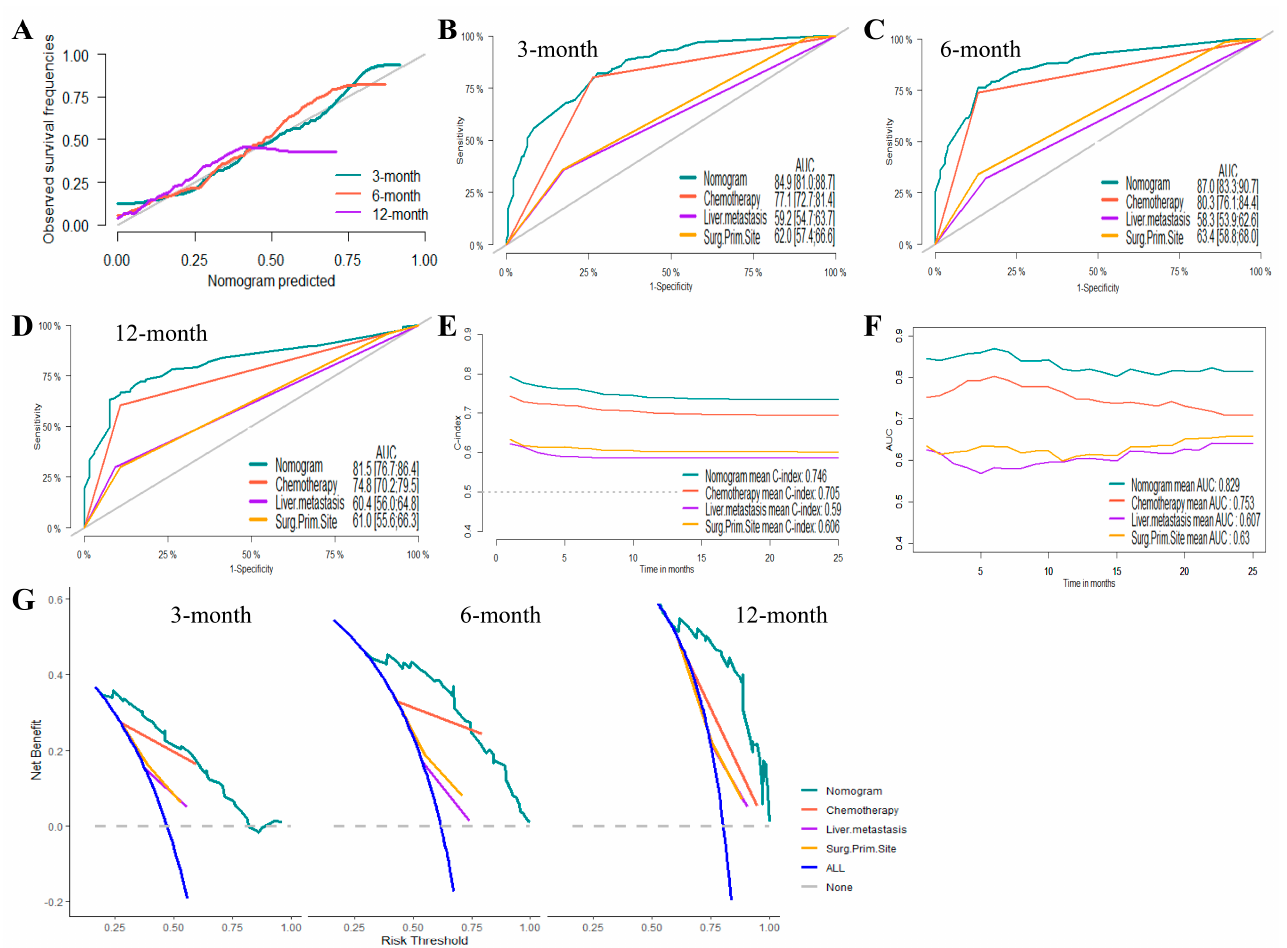
Figure 5. Evaluation of the nomogram on the internal validation dataset for cancer-specific survival (CSS). ( A ) 3-, 6-, and 12-month calibration plots of nomogram. ( B ) 3-month ( C ) 6-month and ( D ) 12- month area under the curve (AUC) for receiver operating characteristic (ROC) curves of nomogram, chemotherapy, liver metastasis, and primary site surgery. ( E ) overall concordance index (c-index) of nomogram, chemotherapy, liver metastasis, and primary site surgery. ( F ) Overall AUC of nomogram, chemotherapy, liver metastasis, and primary site surgery. ( G ) 3-, 6-, and 12-month decision curve analysis (DCA) of nomogram, chemotherapy, liver metastasis, and primary site surgery.